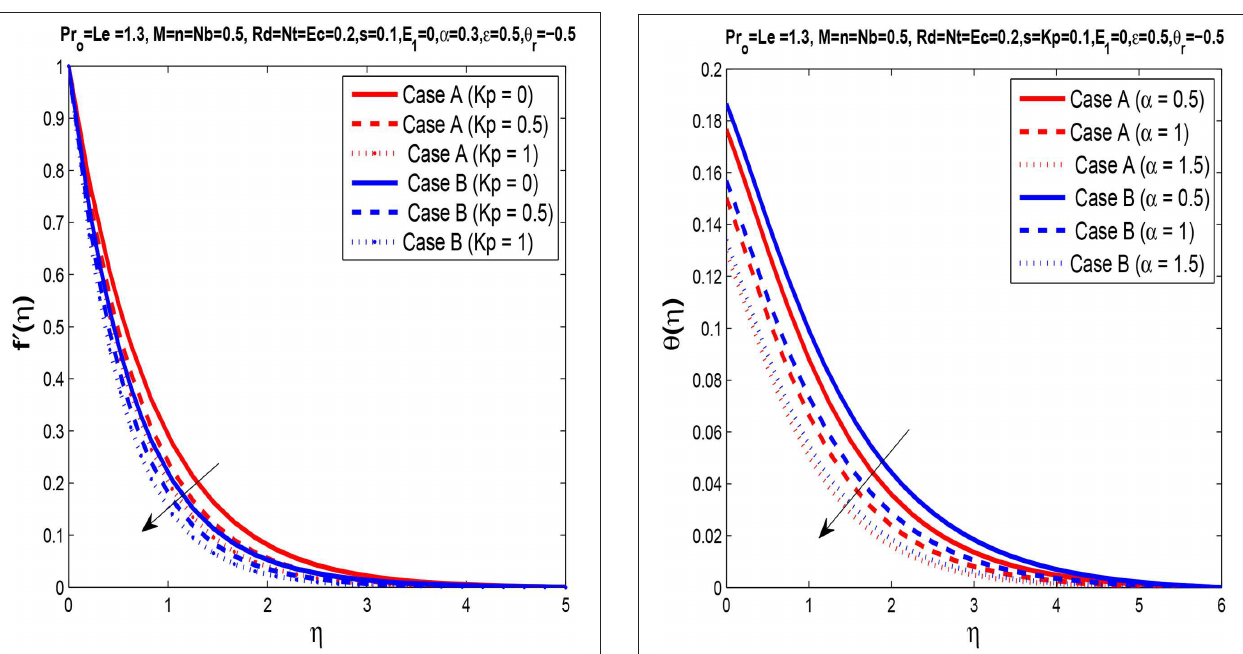
FIGURE 5 | Temperature profile θ ( η ) for different values of α